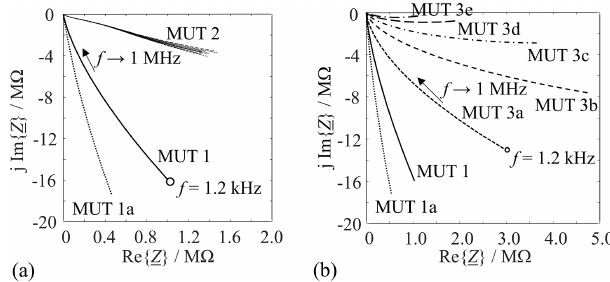
Figure 4. Nyquist plots of the measured molding materials from Table 1 in the frequency range from 1.2 kHz to 1